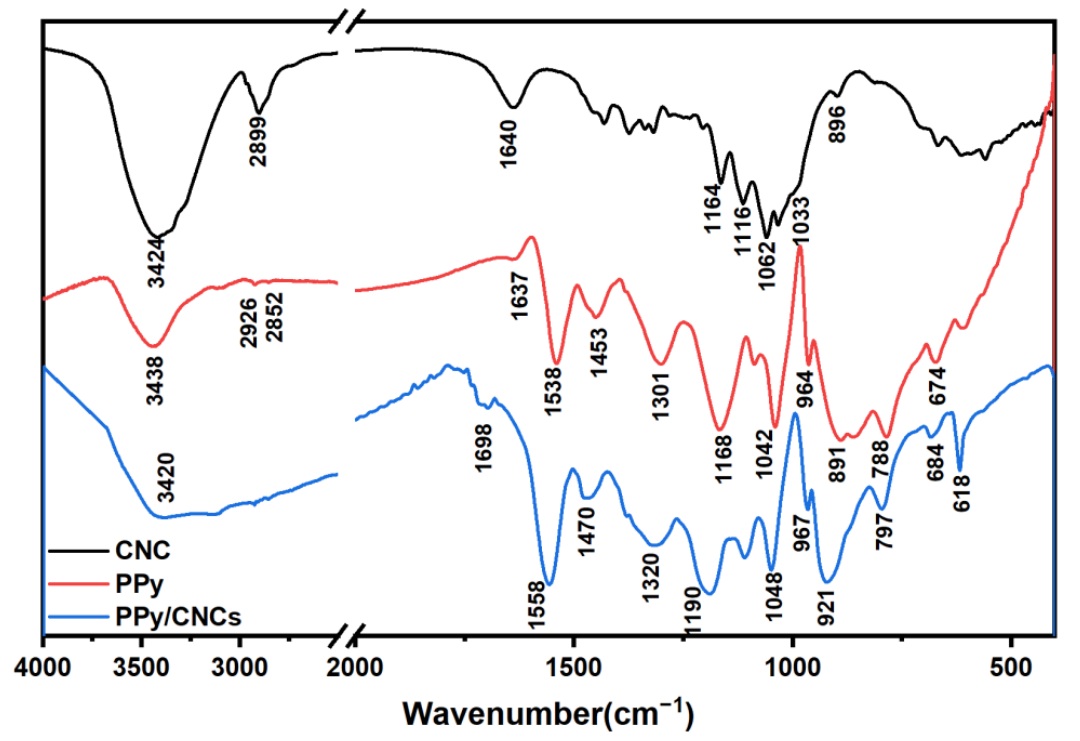
Figure 8. FTIR spectra of CNC, PPy and PPy/CNCs.